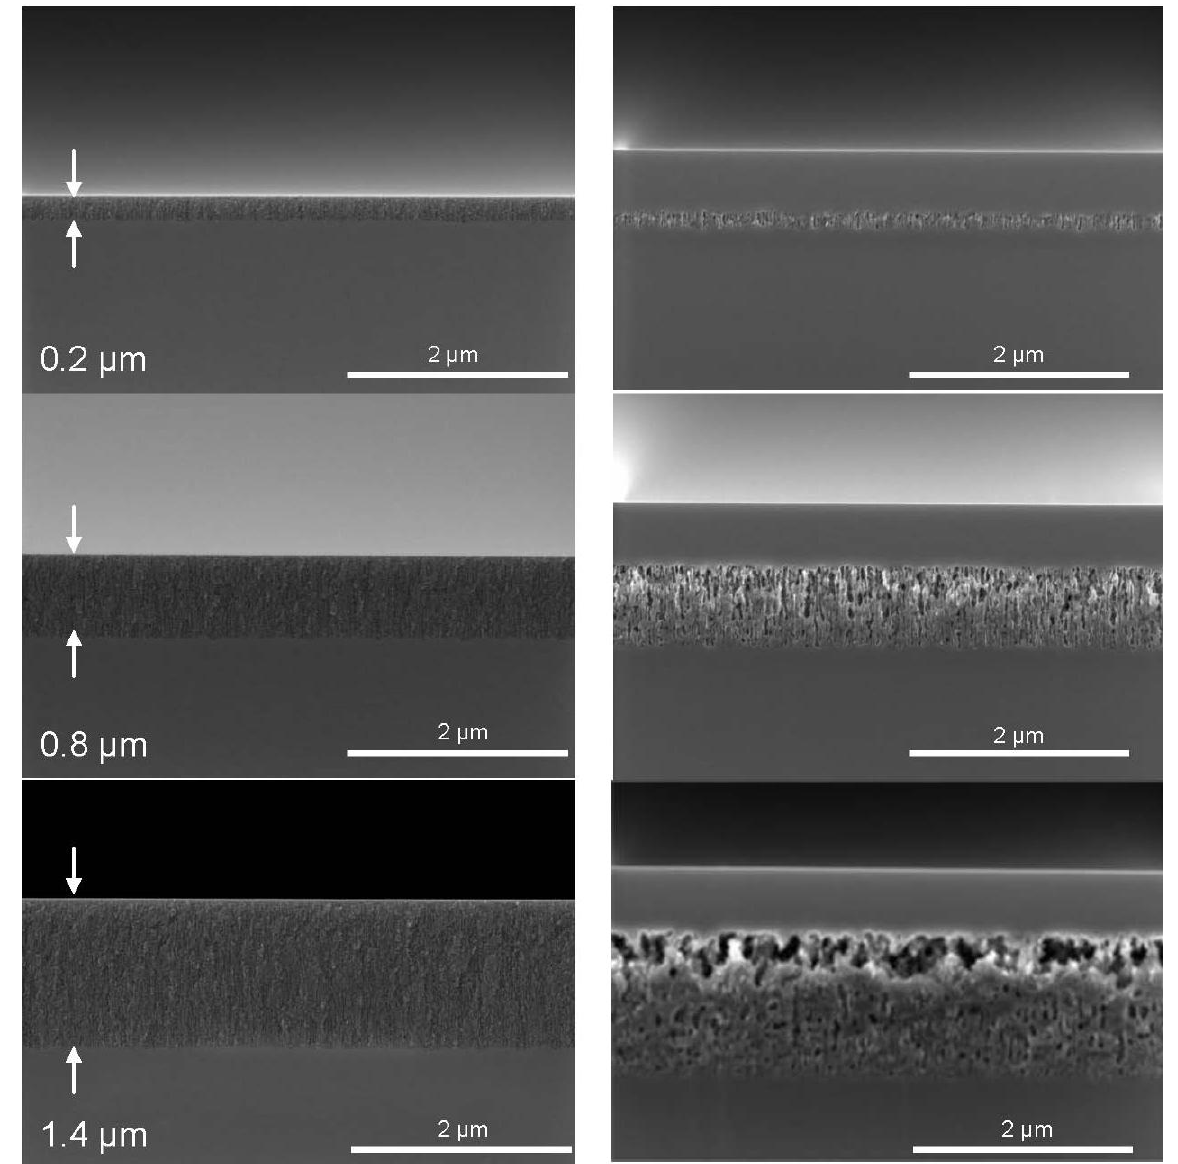
Figure 3. Evolution of the porous layer morphology with increasing thickness. A set of 14 pieces of silicon wafers (100 mm diameter) with a resistivity of 2.2 m  cm was divided in seven pairs. The porous layer thickness was increased by applying the respective etch duration. Left: before the epitaxy process, right: after the epitaxy process. The porosity gradient is not visible in the as etched state but becomes obvious after the epitaxy